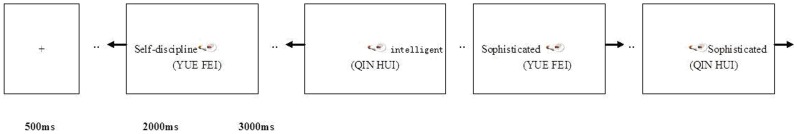
Positive avoidance – negative approach (inconsistent pattern, audition).The Group 6 condition tested an inconsistent pattern based on audition. The pronunciation of the name of a reference object was displayed in the center of the screen, and a corresponding personality adjective appeared at either the left or the right side of the pronunciation.